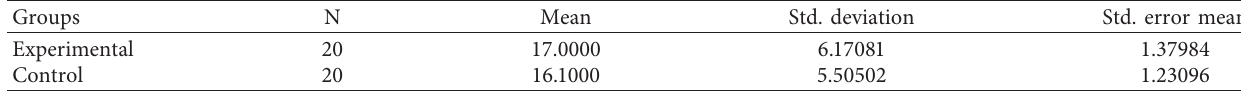
Table 2: Results of descriptive statistics (pretest).